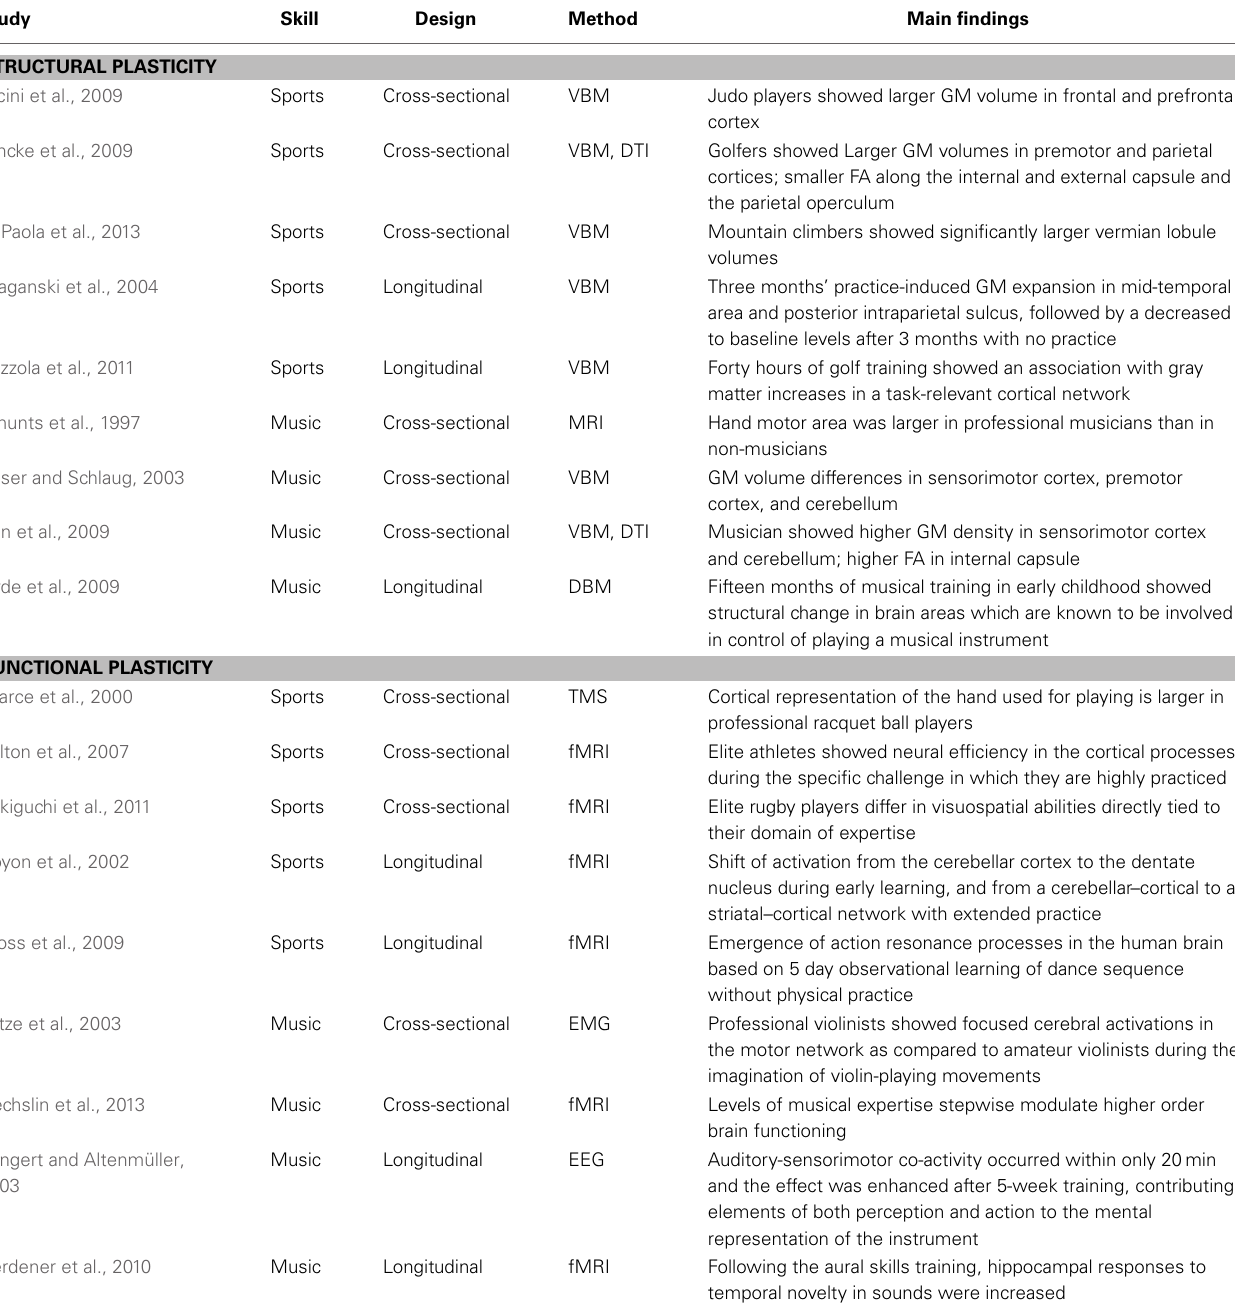
Table 1 | Imaging evidences for structural and functional plasticity in sports and